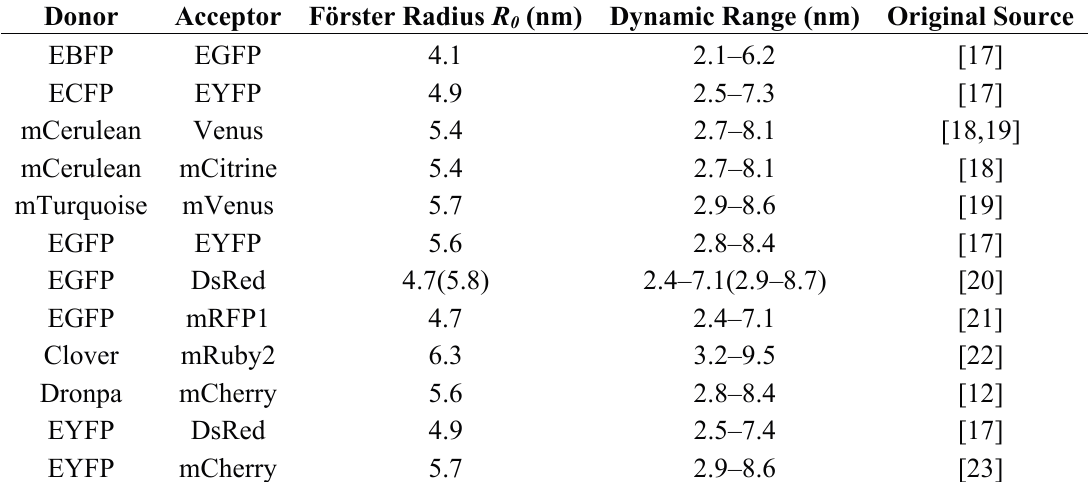
Table 1. The physical properties of several commonly used fluorescent protein FRET-pairs. An excerpt from Müller et al.